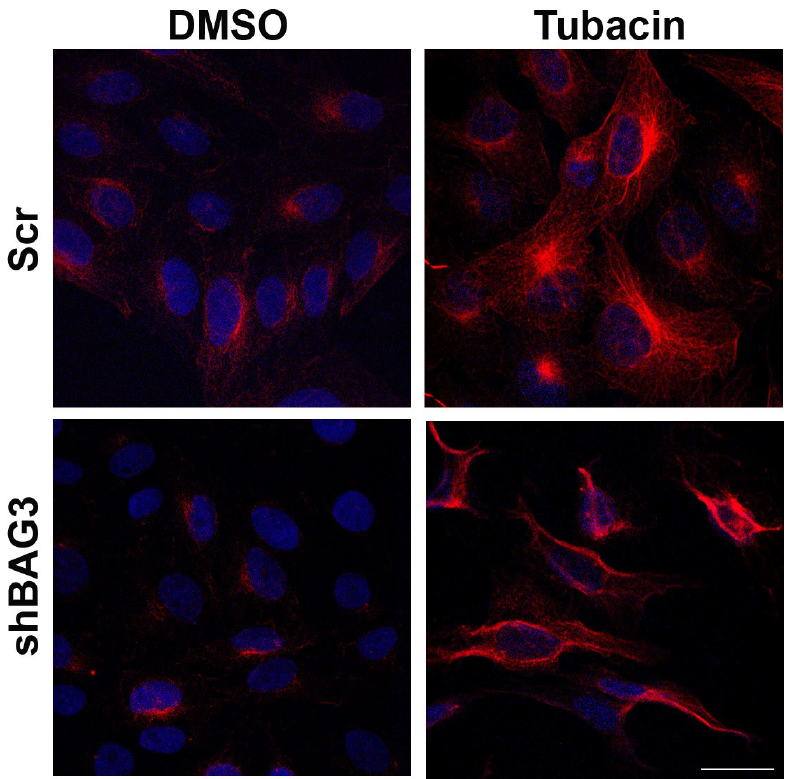
Figure 3. Effect of HDAC6 inhibitor tubacin in shBAG3 cells and Scr control cells. Acetylated tubulin (red) expression in shBAG3 and Scr cells treated with DMSO or HDAC6 inhibitor tubacin (2 µM) for 16 h. Tubacin treated cells showed higher acetylated tubulin staining compared to controls. Bar =